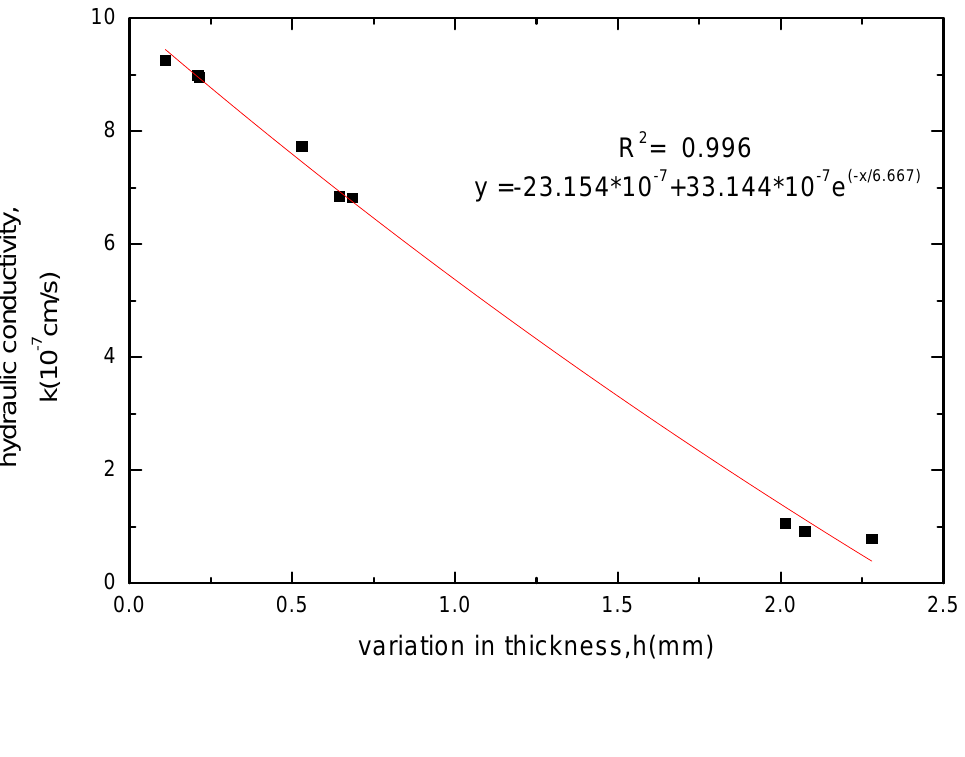
Figure 8. The relationship between hydraulic conductivity and thickness increase for GCL specimens soaked with CaCl 2